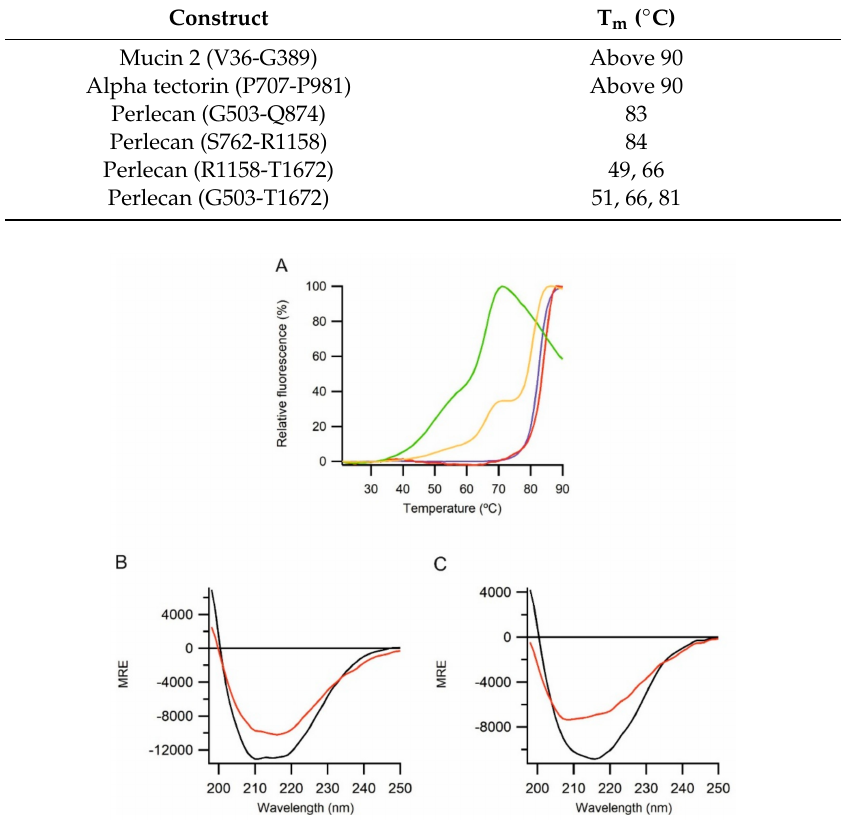
Figure 5. Thermal stability of the purified protein. ( A ) Thermal stability of perlecan region 3 constructs based on thermofluor analysis. A single step thermal transition can be seen for G503-Q874 (blue) and S762-R1158 (red), and a multi-step thermal transition for R1158-T1672 (green) and G503-T1672 (orange). ( B ) and ( C ) Thermal stability of mucin 2 ( B ) and alpha tectorin ( C ) VWF D-domain-containing proteins. CD spectra at 22 ◦ C (black) and 90 ◦ C